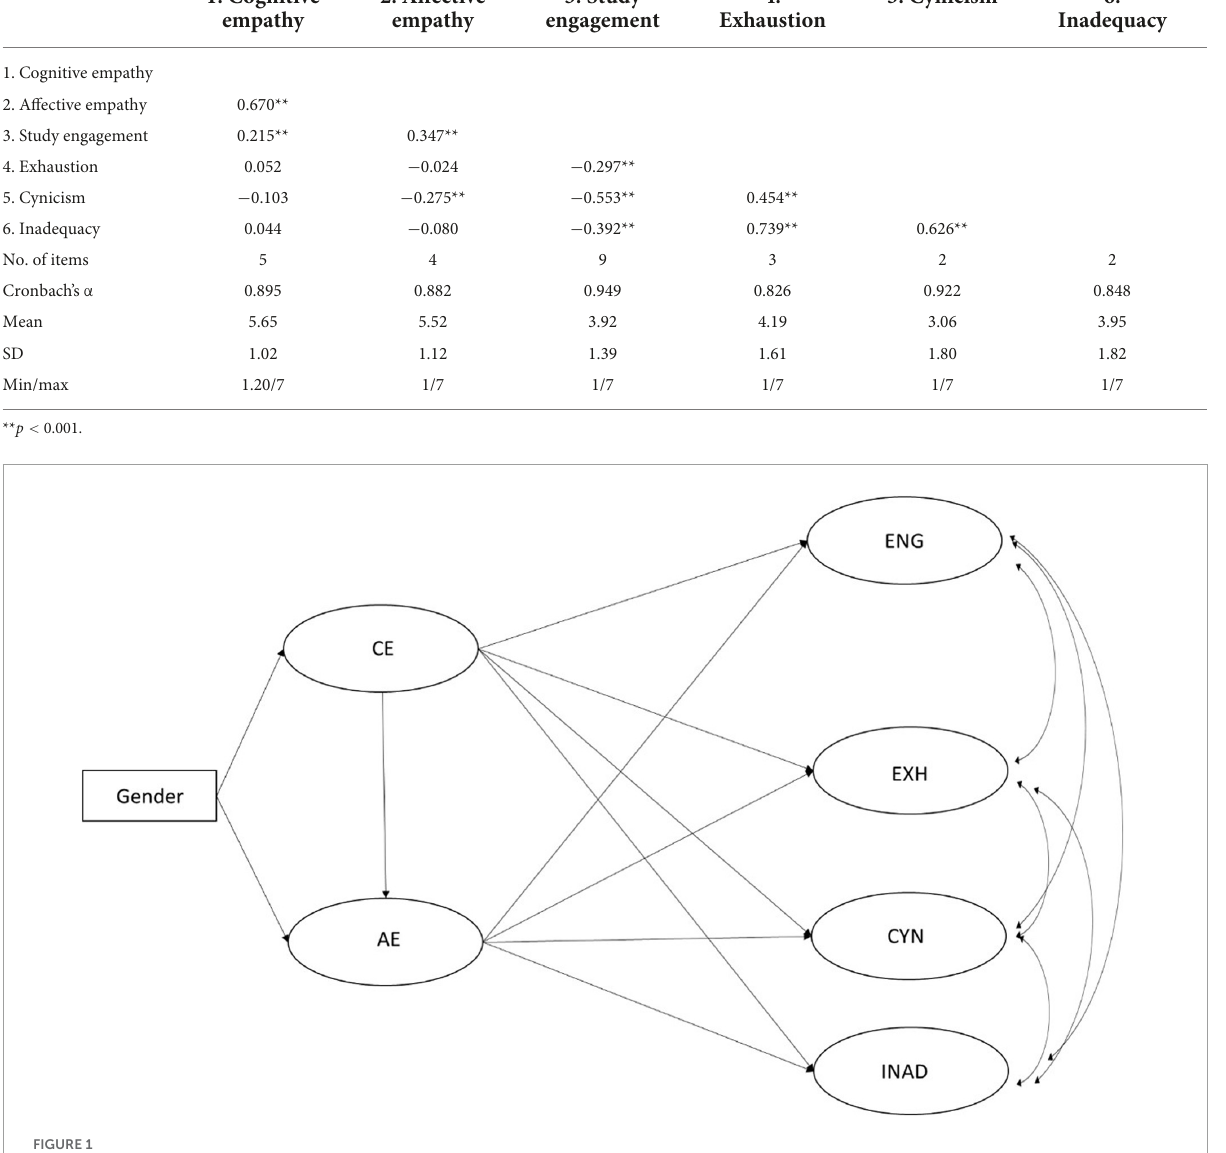
fabric of peer relationship. If prolonged, such experience is likely to become painful, potentially further contributing to social